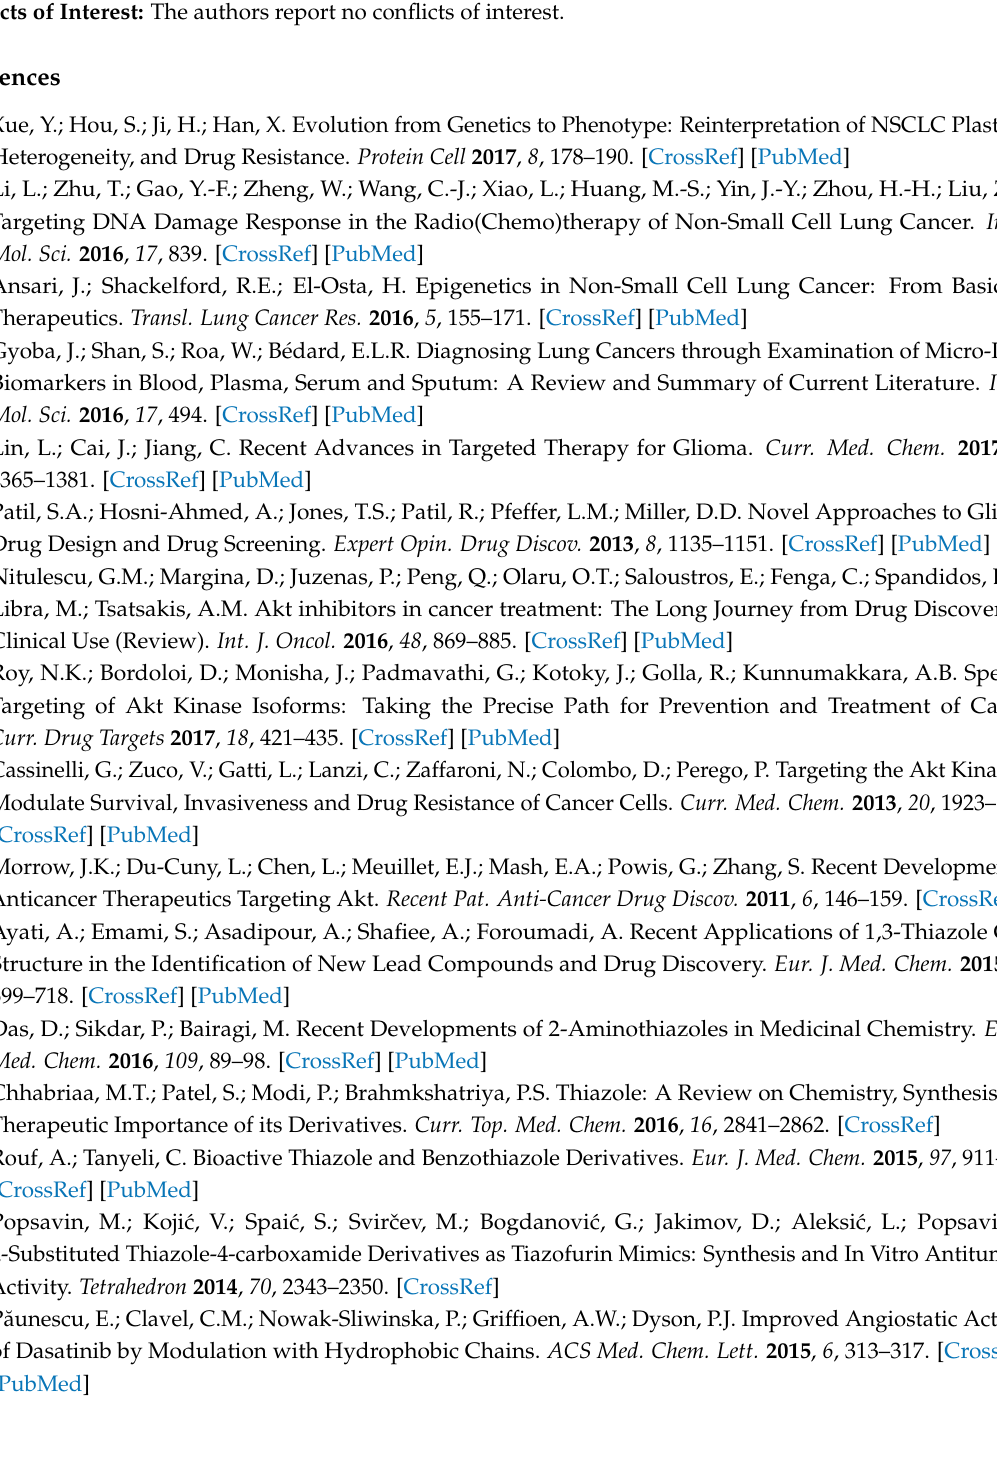
Figure S43: IR Spectrum of compound 10 ; Figure S44: 1 H NMR Spectrum of compound 10 ; Figure S45: 13 C NMR Spectrum of compound 10 ; Figure S46: HRMS Spectrum of compound 10